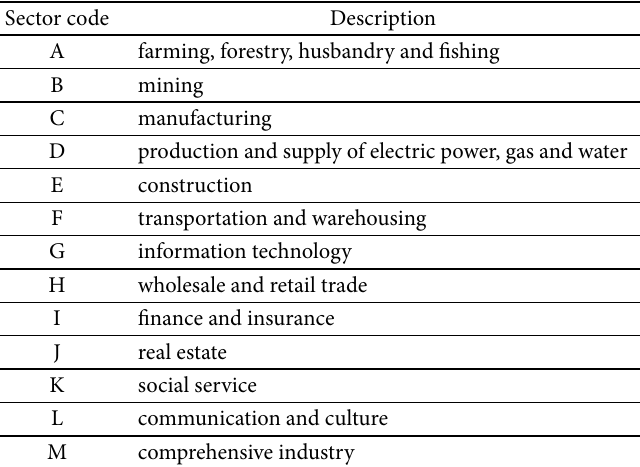
Table 2. 13-sector classification specified by